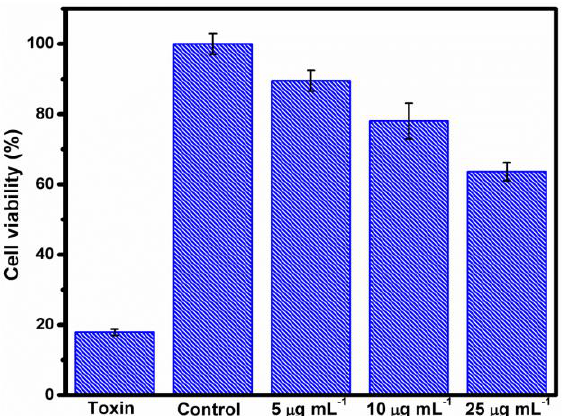
Figure 5. MDA-MB-231 cell viability was assessed by cell proliferation assay (WST-1) on incubation of UCNC@SiO 2 for 48 h. The cell viability was assessed with positive (DMSO) and negative (media only) controls. The cells incubated with 10% DMSO (toxin), showed efficient toxicity with comparatively lowest cell survival or proliferation. However, the negative control cells have approximately 100% cell proliferation. The UCNC@SiO 2 treated cells have shown concentration-dependent cell proliferation i.e. the higher the particle concentration, the lower the cell proliferation. The measured cell viability for 5 µ g mL − 1 , 10 µ g mL − 1 , and 25 µ g mL − 1 UCNC@SiO 2 treated cells were approximately 90%, 80%, and 70%,